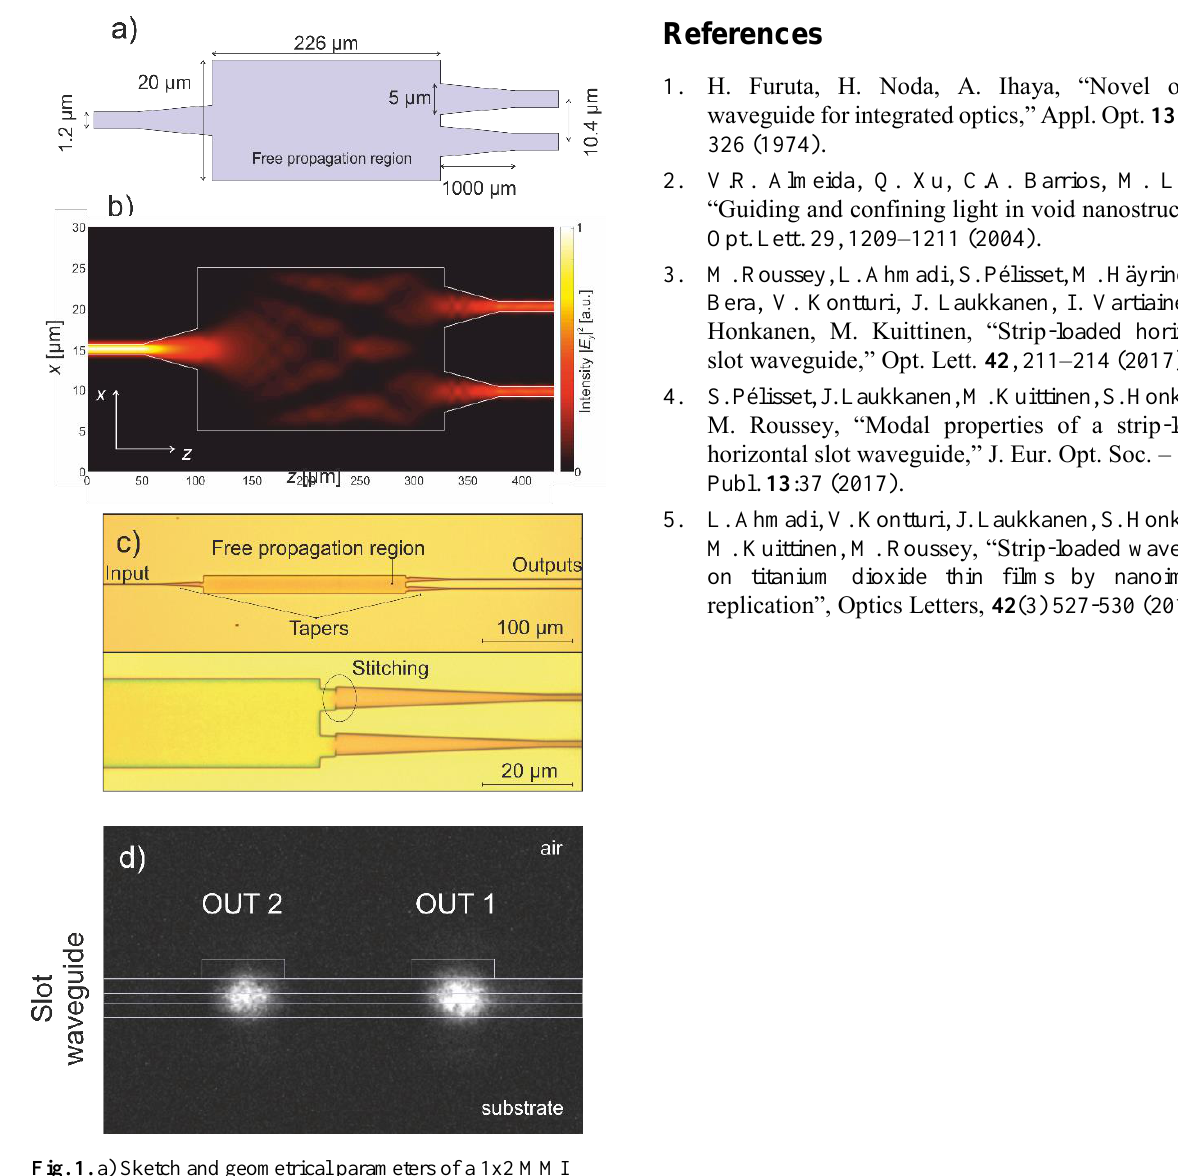
Fig. 1. a) Sketch and geometrical parameters of a 1x2 MMI device on SLSW platform. b) FDTD simulation of the device. The intensity distribution viewed from top is displayed. c) Micrographs of the fabricated device (top: 20x, bottom: 50x). d) Picture taken from the output of the device when illuminated under TM polarization at λ = 1550